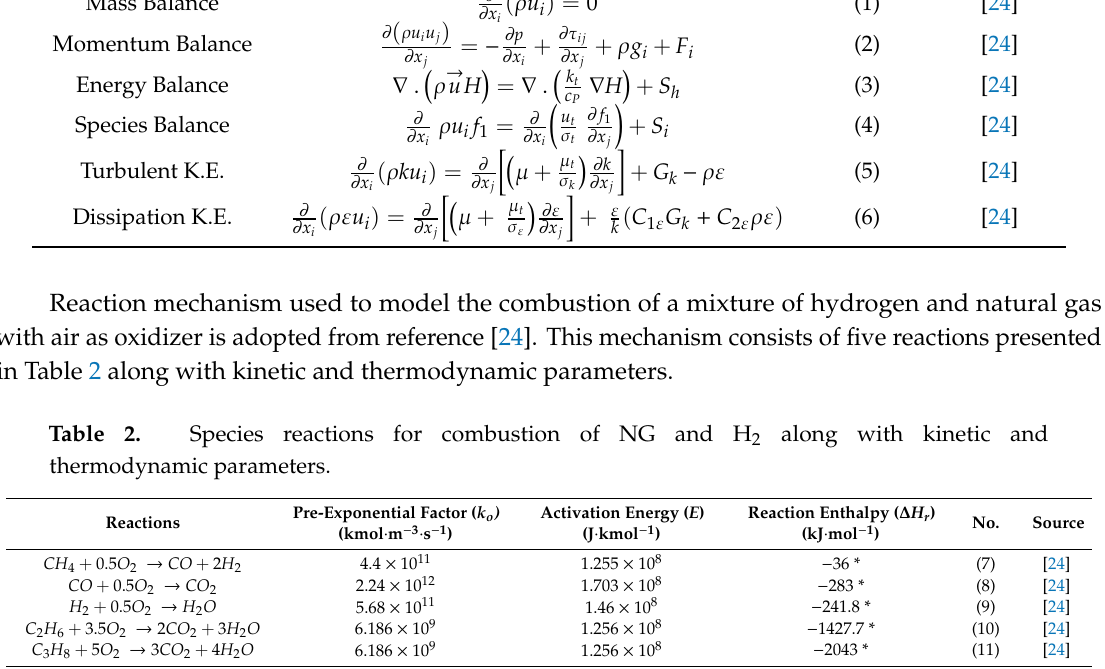
Table 1. Model Equations representing various phenomena taking place in the combustor. Type